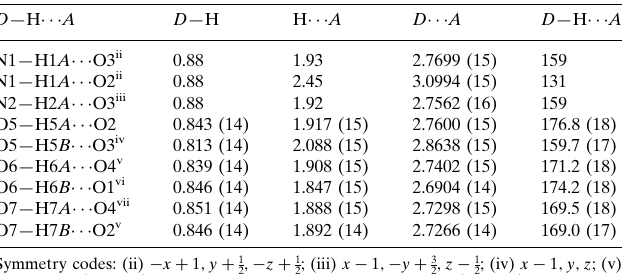
Hydrogen-bond geometry (A˚ , (cid:3)